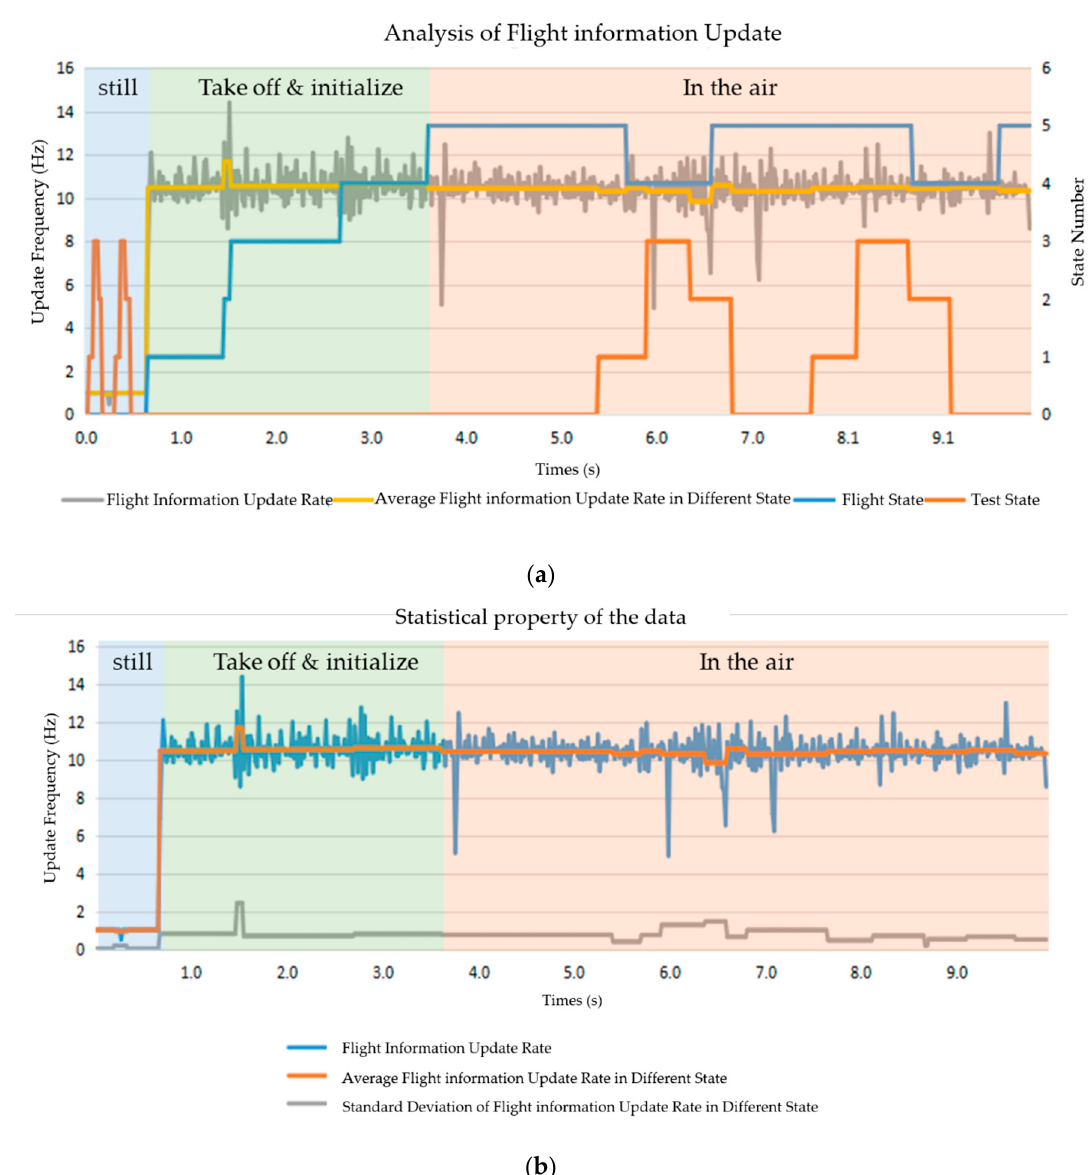
Figure 14. Flight information update analysis: ( a ) Analysis of flight information update rate; ( b ) Statistical properties of the data.